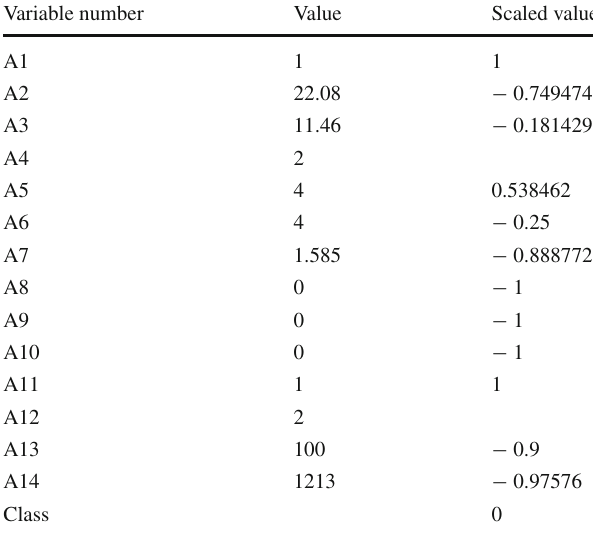
Table 2 An instance of Australian dataset with scaled